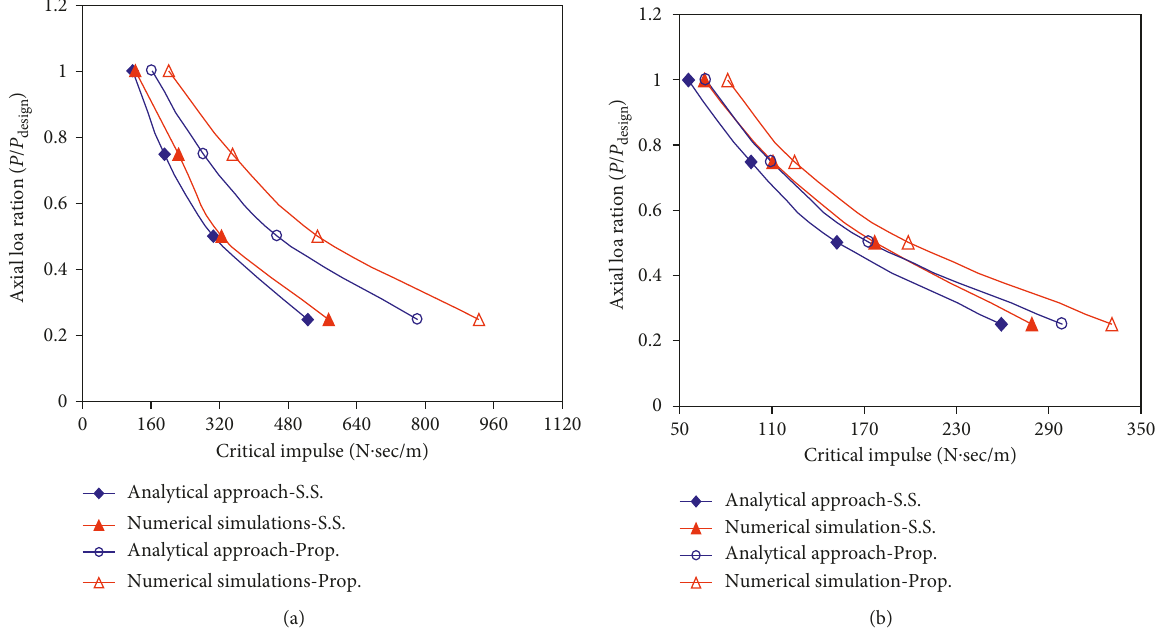
Figure 26: Comparison between analytical method and ABAQUS predictions of critical impulse-axial force curve for steel column section W150 24 with simply supported (S.S.) and propped cantilever (Prop.) boundary conditions and with blast pressure to cause bending about × major and minor axes of the column.